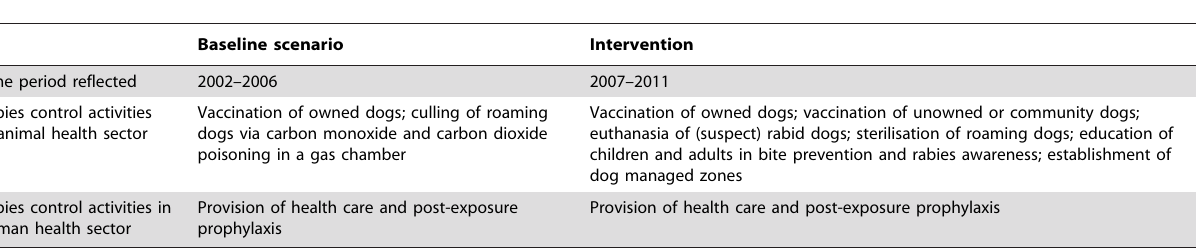
Table 1. Description of the baseline scenario and intervention considered in the